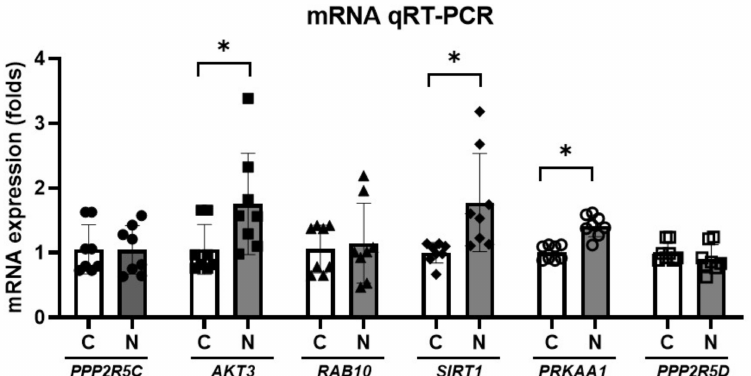
Figure 6. mRNA expression levels of PPP2R5C , AKT3 , RAB10 , SIRT1 , PRKAA1 , and PPP2R5D were higher in the noise-exposed rats than in the control rats ( n = 8 per group; * p < 0.05; unpaired t -test between control and noise-exposed rats).